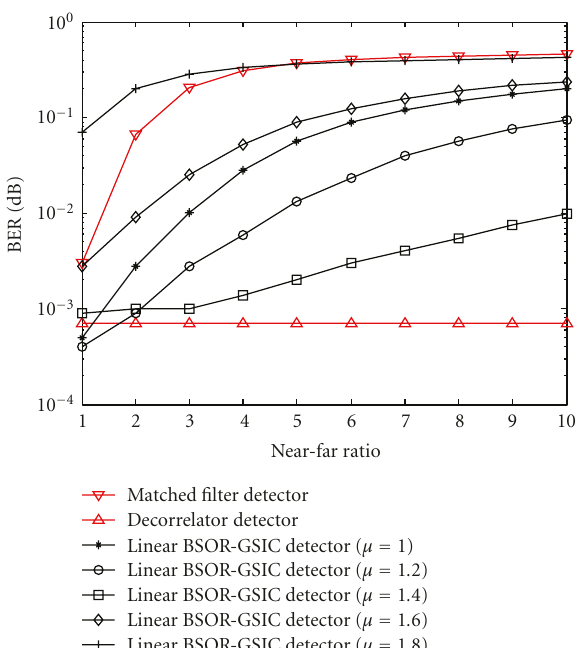
Figure 9: Near-far resistance of the chip-level linear BSOR-GSIC detector for di ff erent values of the relaxation factor ( G = 10).